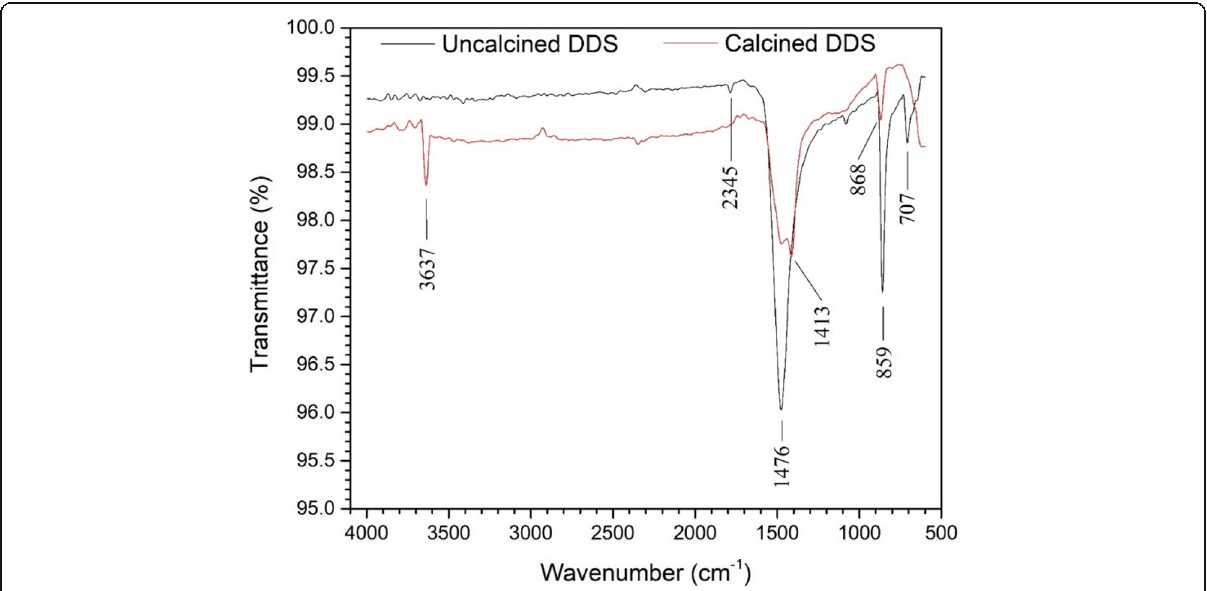
Fig. 3 FTIR spectra of calcined and uncalcined DDS